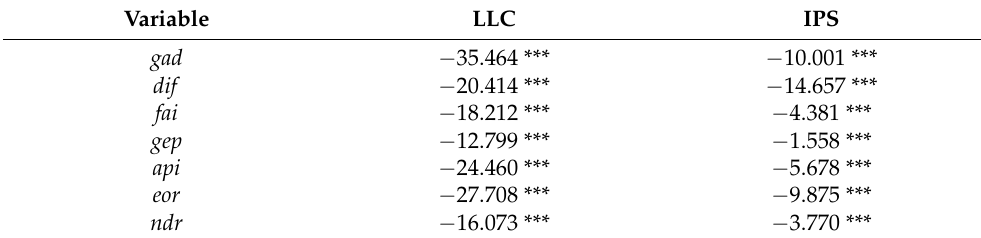
Table 3. Variable stationarity test.